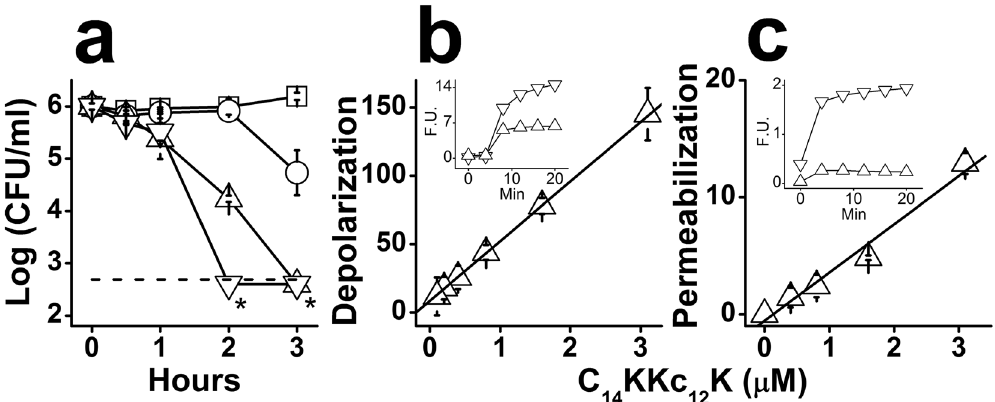
Figure 4. Mechanistic studies (GPB). C 14 KKc 12 K mode of action was investigated against S. mutans ATCC 35668 as GPB representative. ( a ) Bactericidal kinetics upon exposure to 0, 1, 2 and 4 MIC multiples (squares, circles, triangles and inverted triangles, respectively); dashed line, limit of detection (500 CFU/ml); asterisks denote lack of detected CFUs. ( b , c ) Membrane damages instigated by C 14 KKc 12 K, expressed as percentage of the positive control dermaseptin S4(1–15) at 6.25 µ M. Membrane depolarization ( b ) assessed by displacement of DiSC 3 (5), and membrane permeation ( c ) assessed by accumulation of EtBr. The insets in ( b and c ) show representative depolarization and permeation kinetics, of the OAK (triangles) and the positive control (inverted triangles) at 0.78 and 6.25 µ M, respectively; Min, minutes; F.U., fluorescence units (excitation: 620 nm, emission: 680 nm in panel b; excitation: 535 nm, emission: 590 nm in panel c). Results are from at least two independent experiments performed in duplicate. Error bars represent the standard